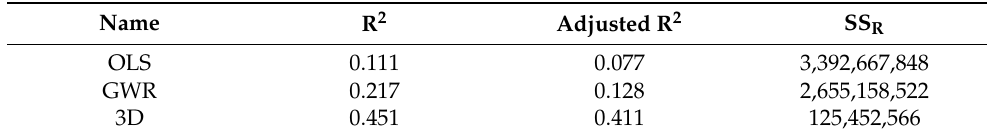
Table 8. Comparison of 2D and 3D